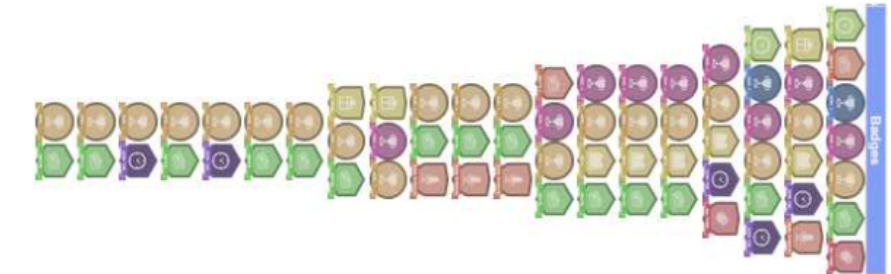
Figure 9. Badges per student (indexes of students in the ranking of merit points from top to bottom: 1, 9, 2, 4, 7, 5, 8, 3, 16, 14, 11, 6, 21, 22, 20, 12, 10, 17, 15,